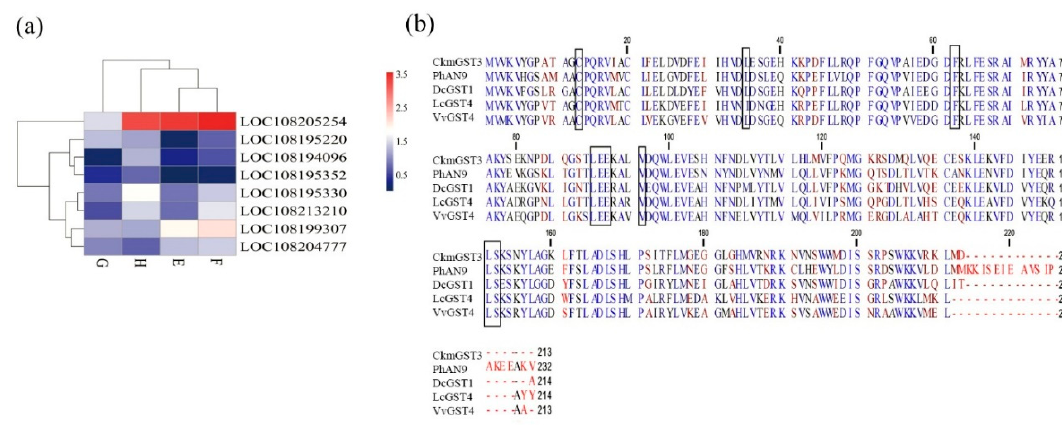
Figure 4. Expression patterns of DcGST s and deduced amino acid sequences analysis. ( a ) Heatmap of DEGs of GST across four comparisons in different tissues. Expression values of four libraries are presented as normalized log10 (RPKM + 1). Red and blue colors indicate upregulated and downregulated transcripts, respectively. E (xylem of ‘Purple 68 ′ ), F (phloem of ‘Purple 68 ′ ), G (xylem of ‘Purple Haze’) and H (phloem of ‘Purple Haze’). ( b ) Multiple alignments of deduced amino acid sequences of DcGST1 (LOC108205254) with other functionally anthocyanin-related GSTs. Black boxes represent amino acid residues of GST involved in anthocyanin transporting [47]. The GenBank accession numbers are PhAN9 (CAA68993), CkmGST3 (BAM14584), VvGST4 (AAX81329), and LcGST4 (ALY05893).